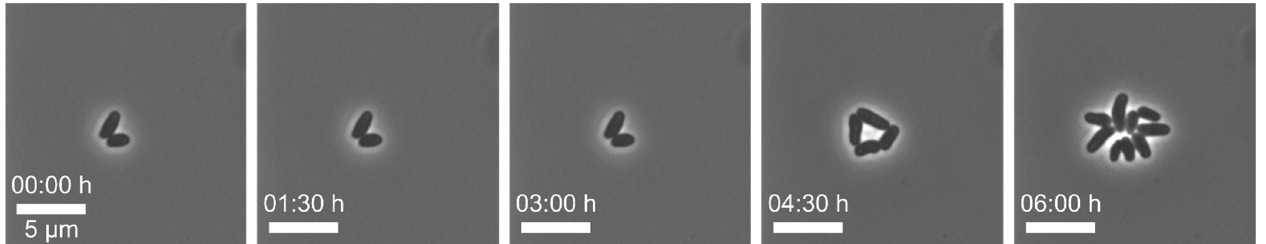
Figure 5. Microscopic images of C. glutamicum with an increased lag phase in the first three hours of cultivation (scale bar = 5 μ m).